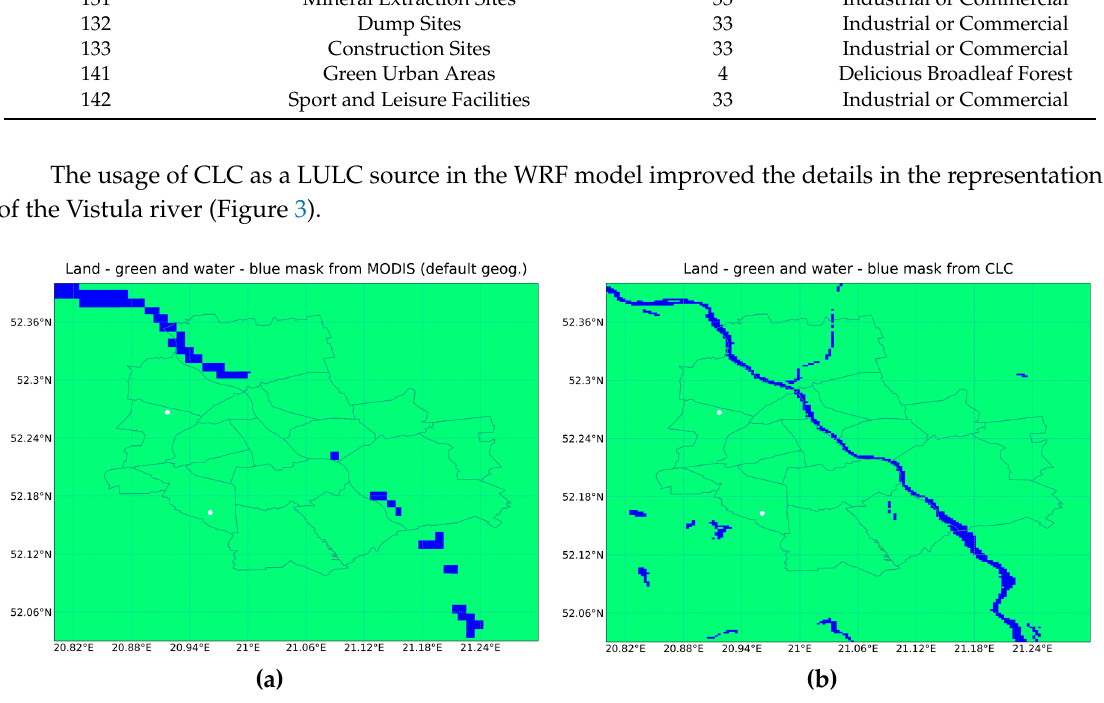
Table 4. Scheme of reclassification for the urban area LULC categories, from CLC to MODIS classes. 244